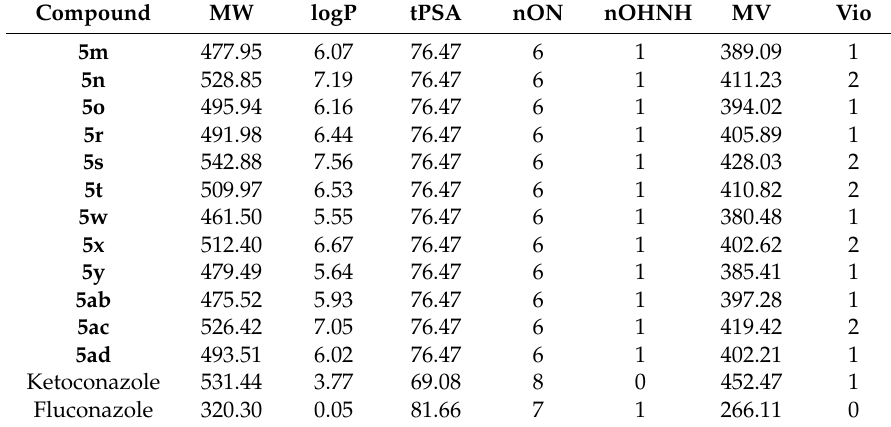
Table 3. Calculated ADME parameters and DLS of compounds 5a – 5ad . Compound MW